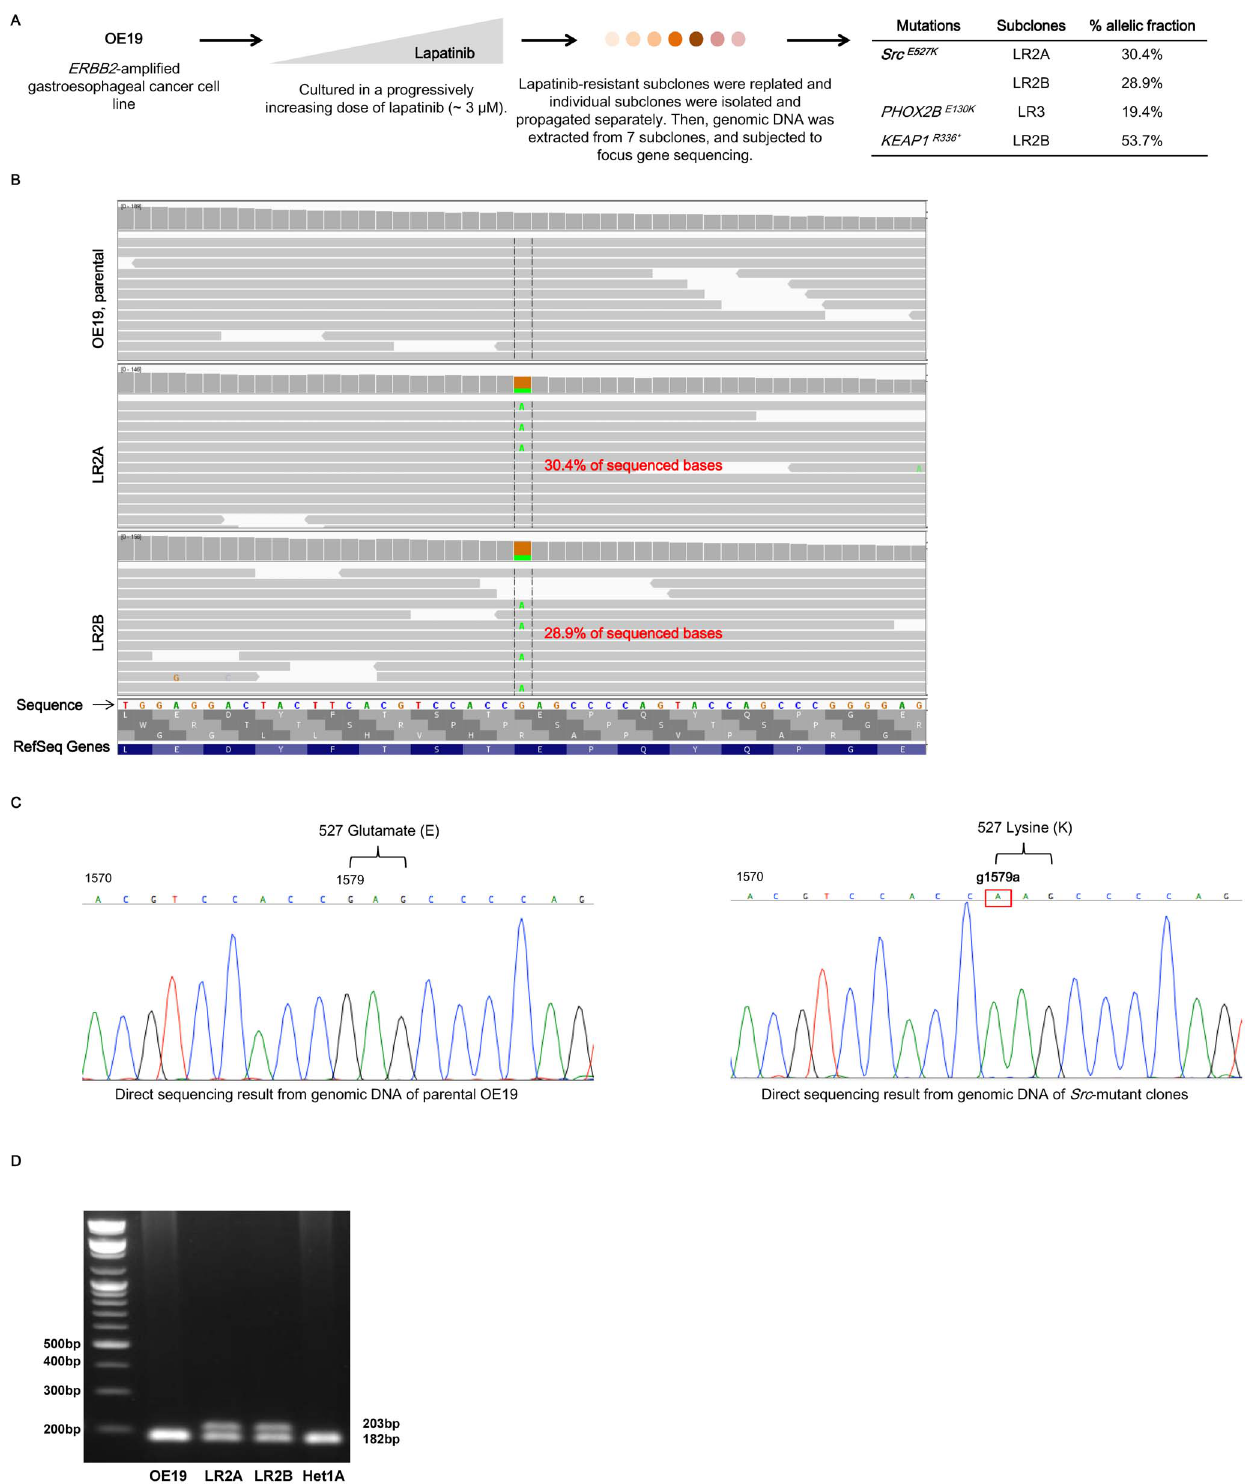
Figure 1. Generation of lapatinib-resistant (LR) OE19 subclones, and the identification of a novel, acquired Src E527K mutation. A, Schematic view of the development of lapatinib resistance OE19 cells followed by subcloning of distinct clones of resistant cells for genomic characterization. At right is the listing of somatic alterations identified in the distinct subclones, compared to the genome of the parental OE19 cells. The allelic fraction of each mutation, percent of sequenced reads with the mutant allele, is listed for each candidate mutation. B, IGV (Integrated Genomic Viewer) snapshot of Src mutations in two LR subclones compared to the sequencing seen from this locus in the parental, lapatinib-sensitive cell line. C, Direct sequencing results from genomic DNA from both parental OE19 cells and Src E527K mutant LR2A and LR2B subclones identifies mutation detected from next-generation sequencing. D, DNA restriction analysis results using Ban II enzyme, from the genomic DNA from the